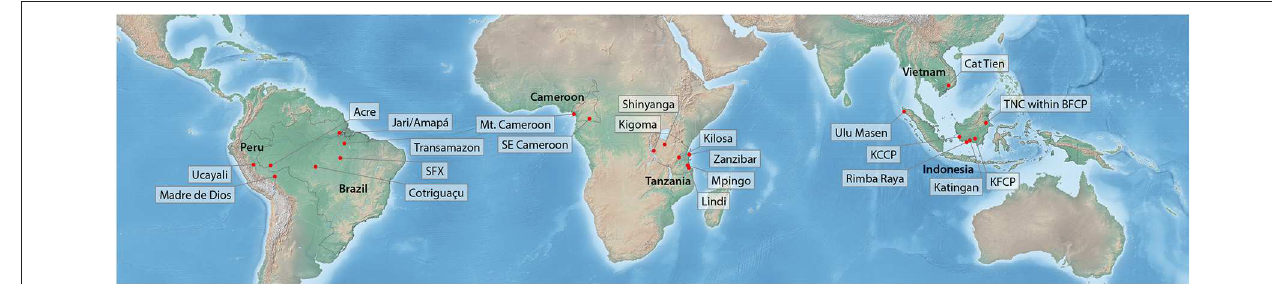
(59%), followed by access and conversion restrictions